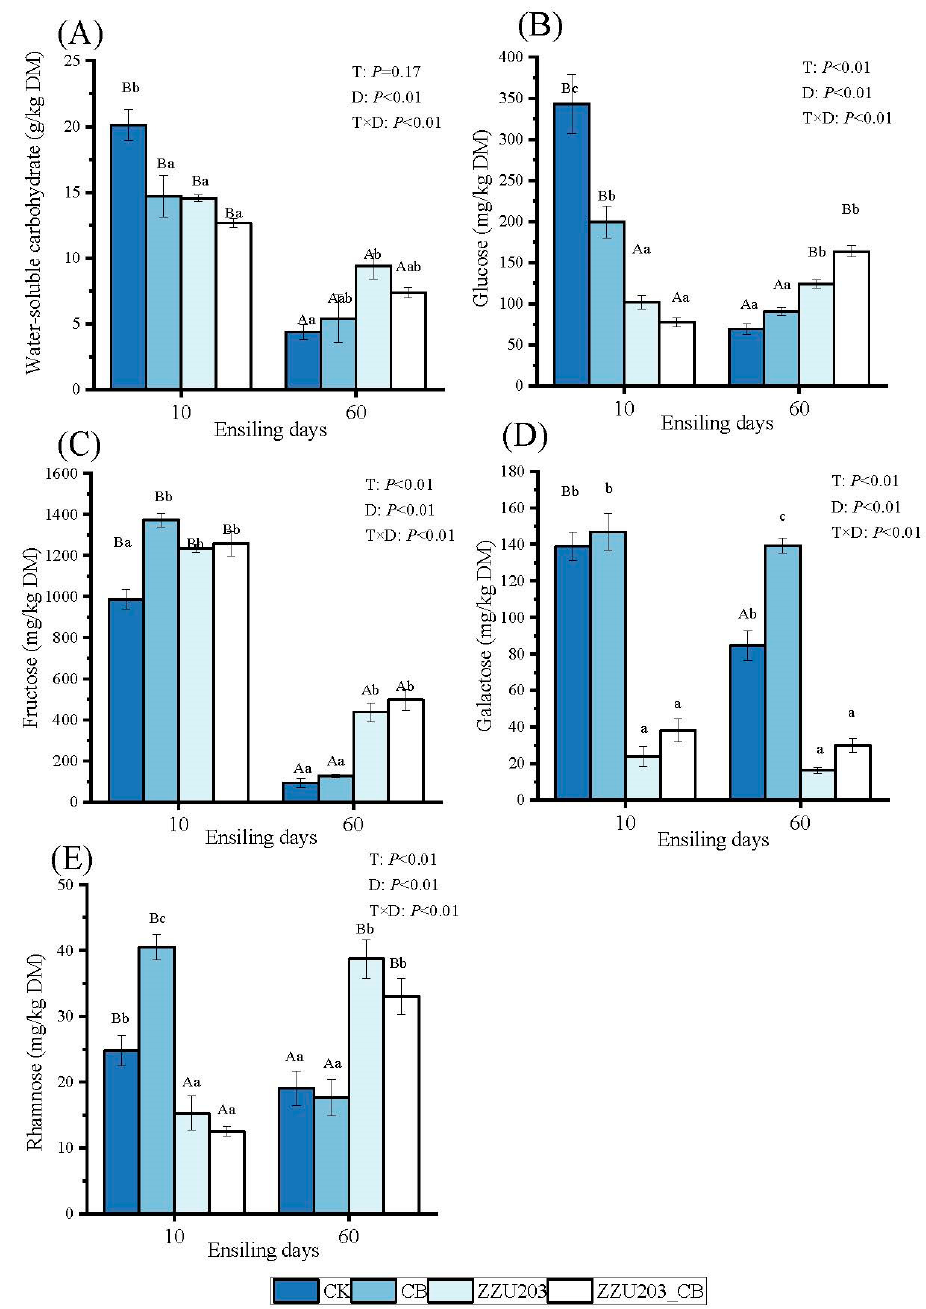
Figure 2. Changes in the concentrations of water-soluble carbohydrate (WSC) ( A ), Glucose ( B ), Fructose ( C ), Galactose ( D ) and Rhamnose ( E ) in alfalfa silages during ensiling for 60 d. Values with different superscript lowercase letters show significant differences between treatments on the same ensiling day, values with different superscript capital letters show significant differences between ensiling days with the same treatment ( p < 0.05).